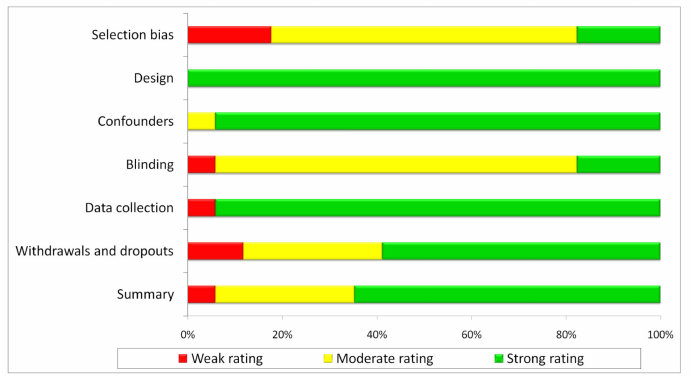
Figure 2. Review authors’ judgements about each quality section item presented as percentages across all included